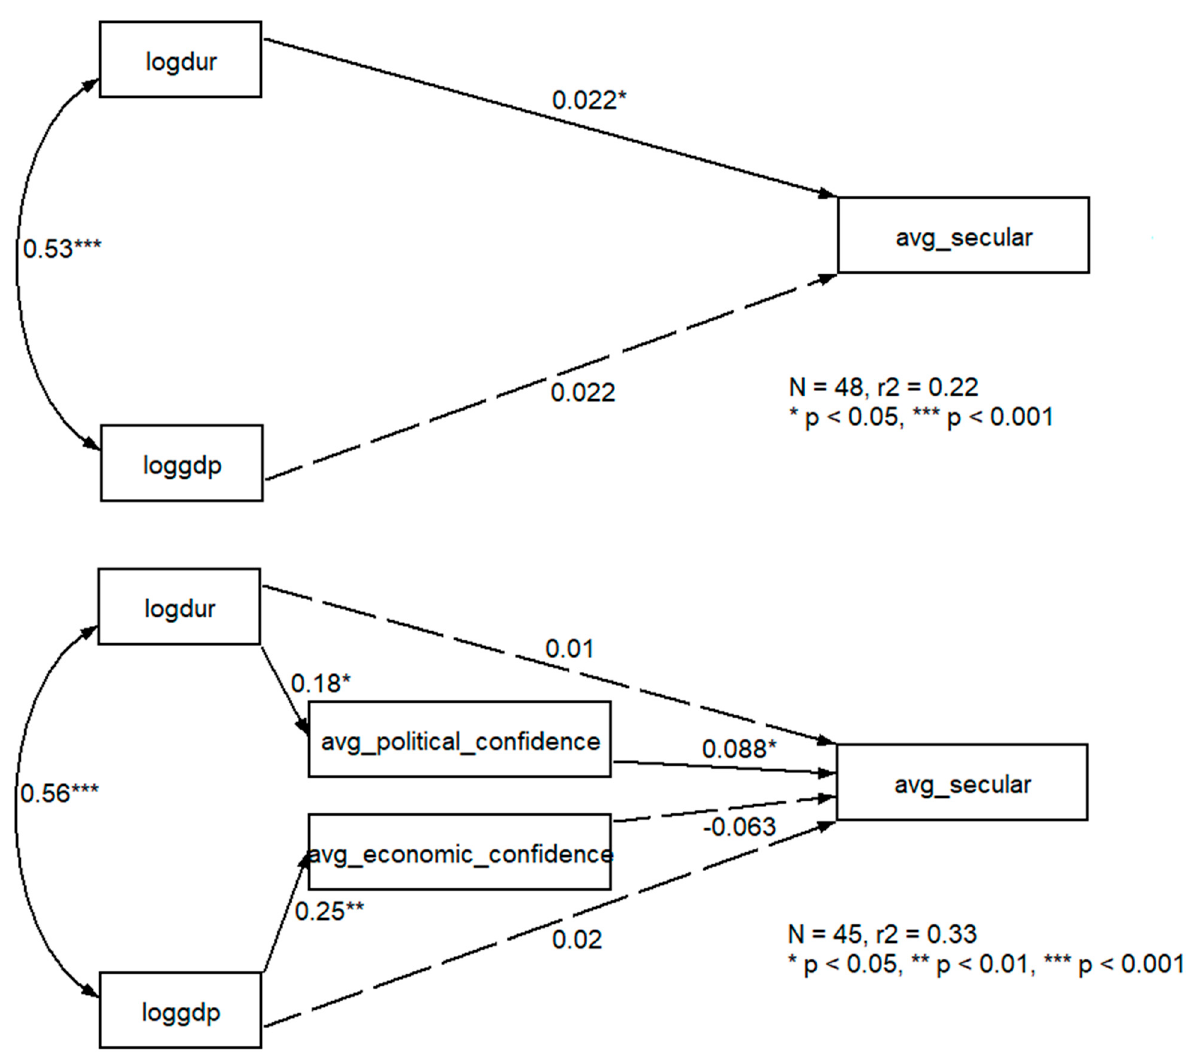
Figure A2. SEMs for secular values (using logdur as a proxy for political stability). Note: Solid lines are used to denote significant paths. Table A1. Mediation analyses on secular and emancipative values (using logdur as a proxy for political stability).